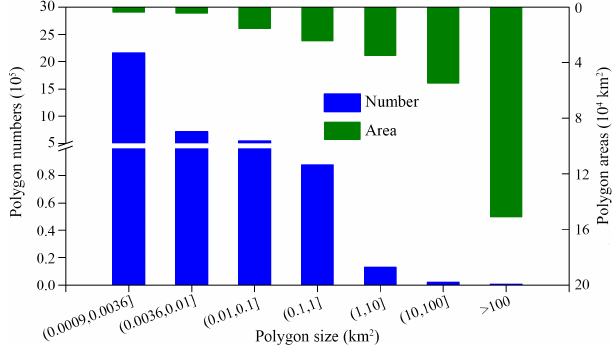
Figure 6. Numbers and areas of yearlong surface water body poly- gons with different